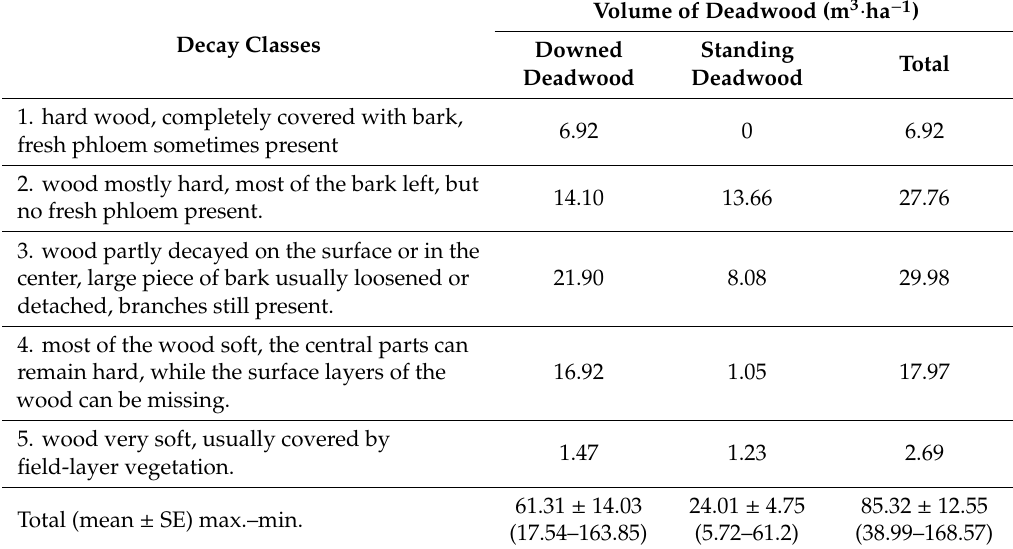
Table 1. Deadwood volume (total, downed, standing), snag density and distribution on decay classes (mean values ( ± SE)